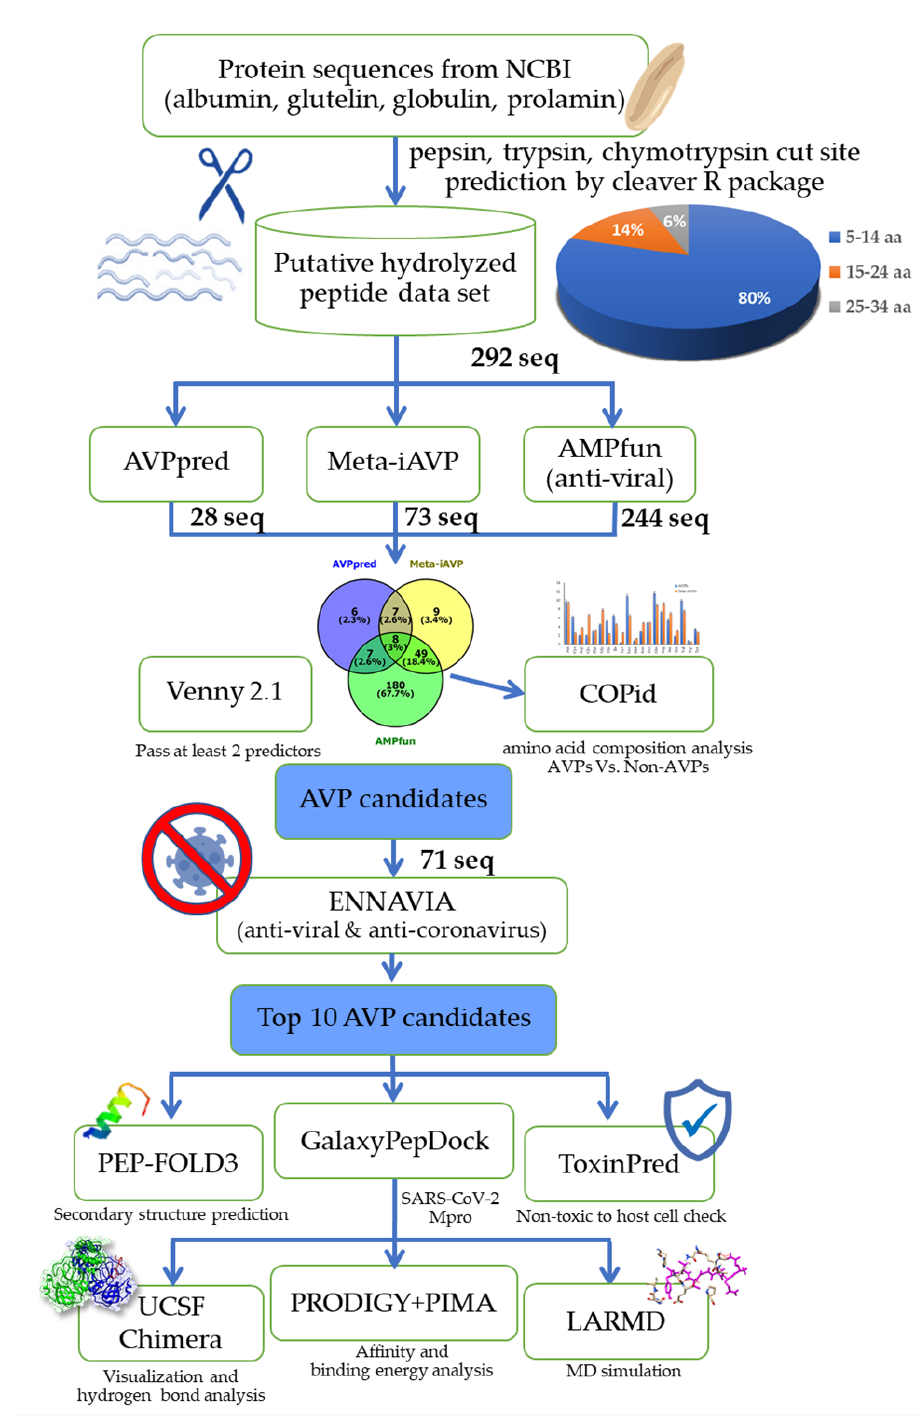
Figure 1. The workflow of the bioinformatic virtual screening for antiviral peptide (AVP) candidates and the in silico analysis of the SARS-CoV-2 main protease inhibition using molecular docking simulation.